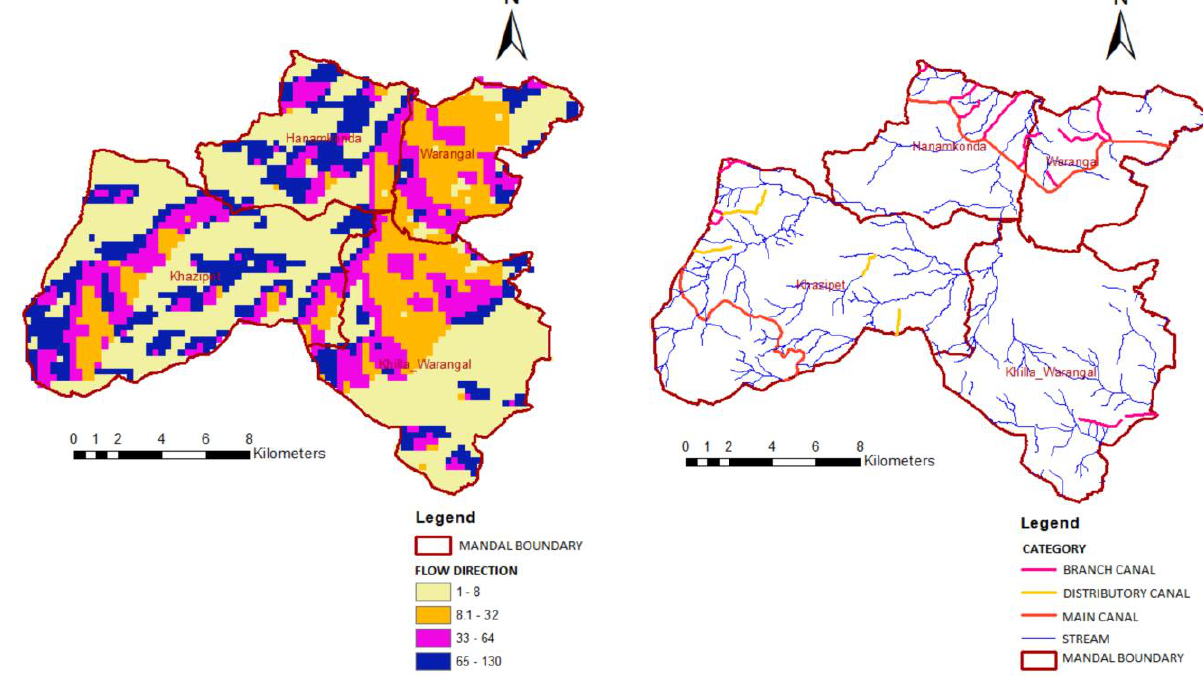
Fig. 4a. Flow direction map Fig. 4b. Streams delineated